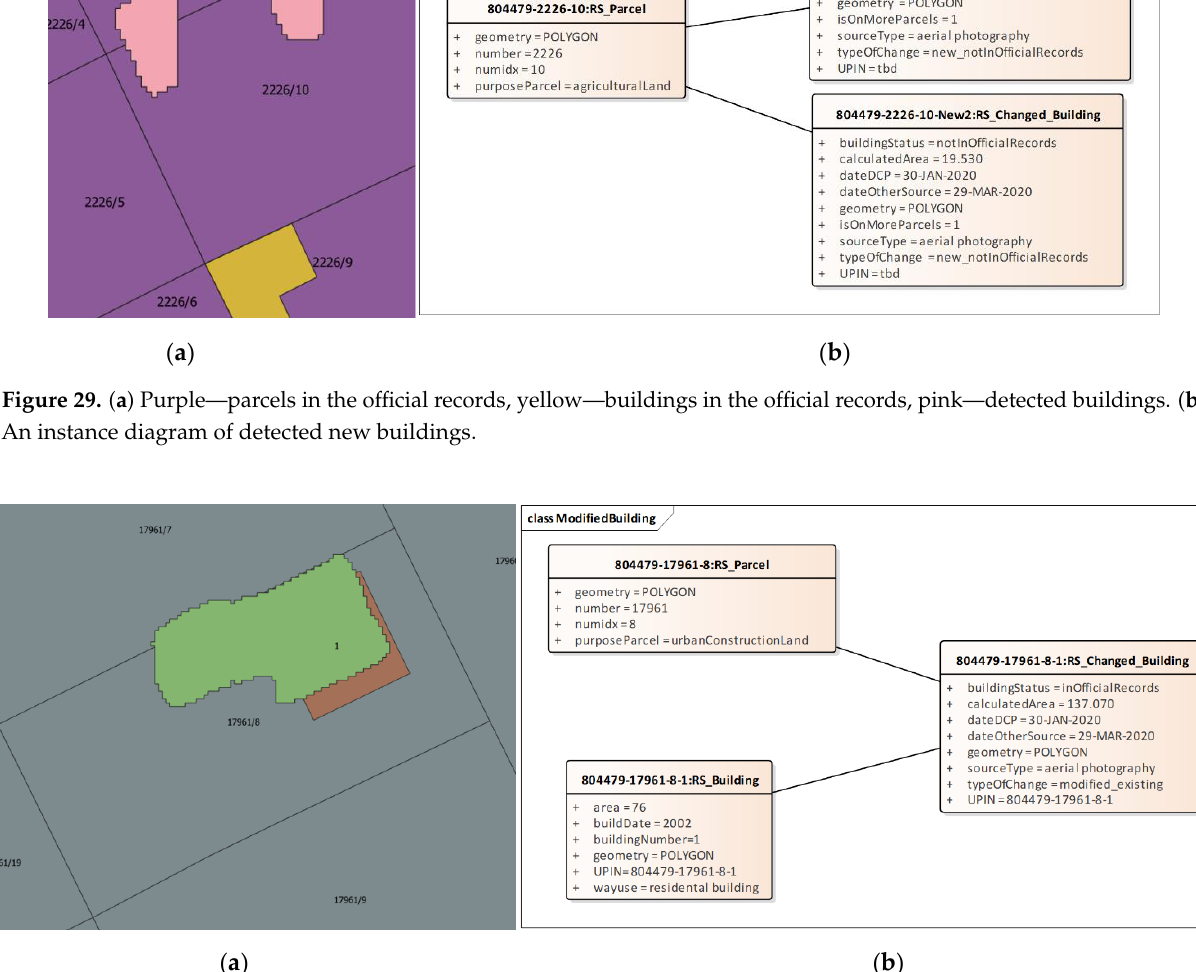
Figure 30. ( a ) Blue—parcels in the official records, red—buildings in the official records, green—detected buildings. ( b ) An instance diagram of detected change on the building.